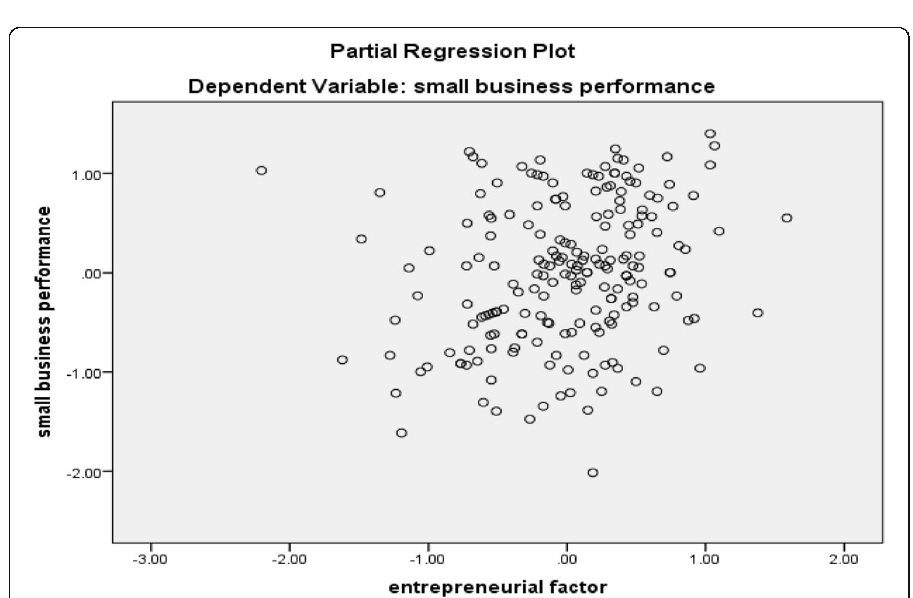
Fig. 5 Partial regression plot of independent variable entrepreneurial